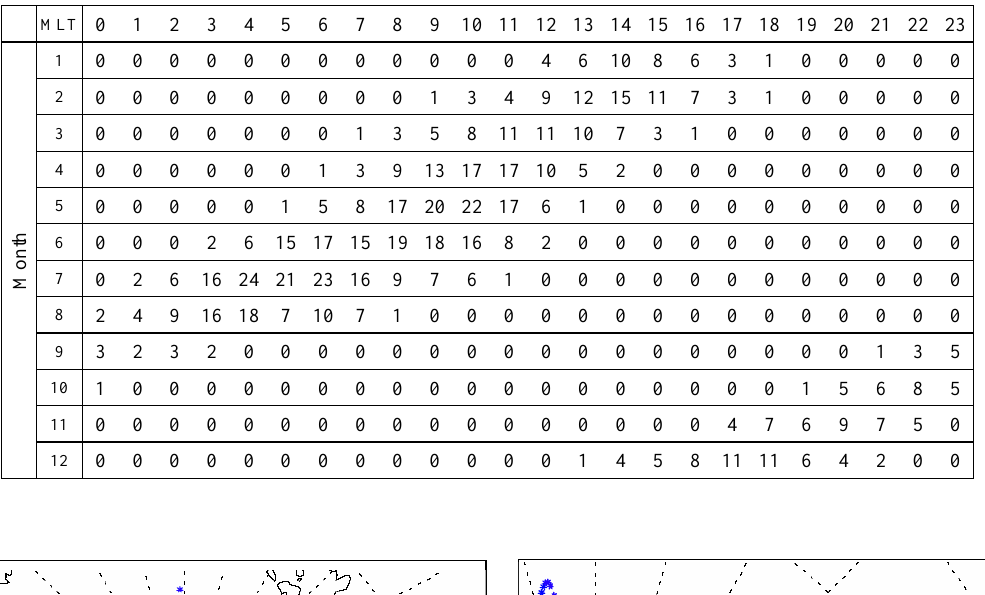
Table 4. The times of conjunctions between TC-1 spacecraft and ZHS, listed according to different magnetic local times and different months.